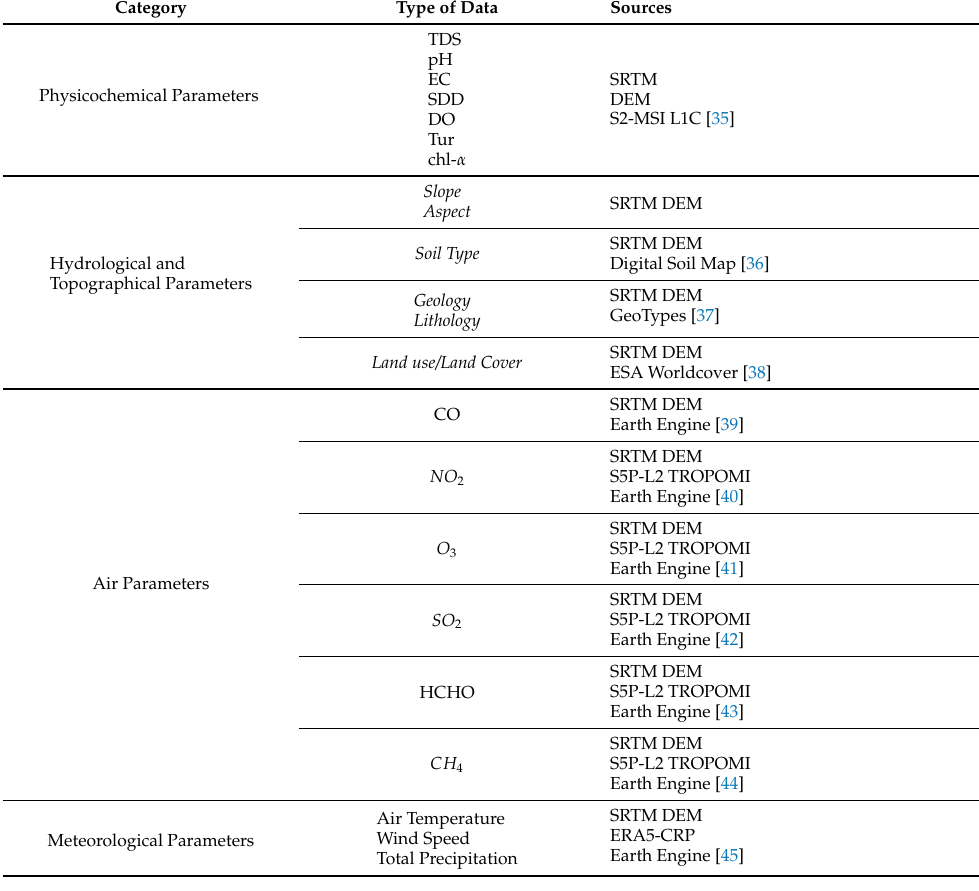
Table 2. Types of data acquired and their sources.